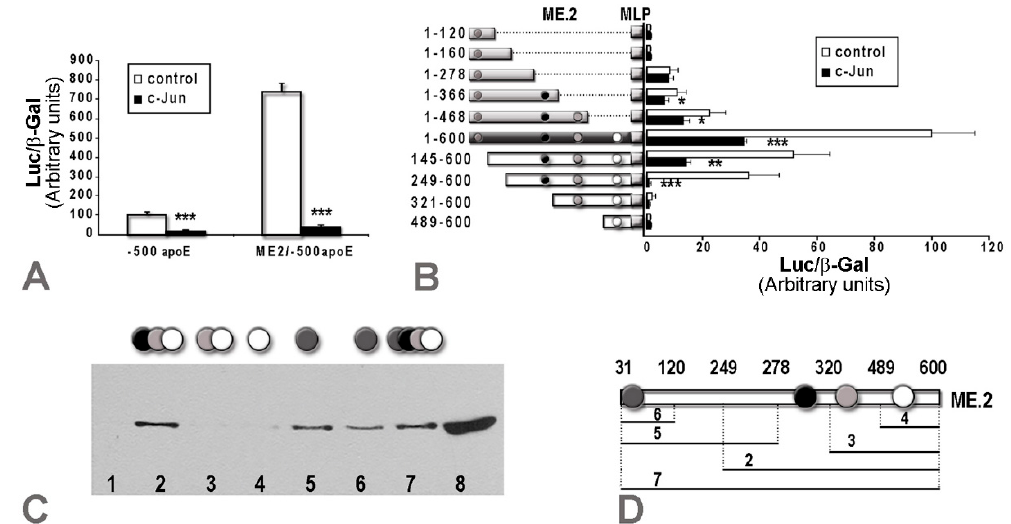
Figure 2. In macrophages, c-Jun bound to ME.2 inhibited apoE promoter activity. ( A ) RAW 264.7 macrophages were transiently transfected with -500apoE construct or ME.2/-500apoE construct in the absence (control) or in the presence of c-Jun expression vectors: c-Jun overexpression in RAW 264.7 cells caused a reduction in the activity of the -500apoE promoter to ~30% of the control ( p < 0.001), while in the presence of ME.2 (ME.2/-500apoE construct), apoE promoter activity drastically